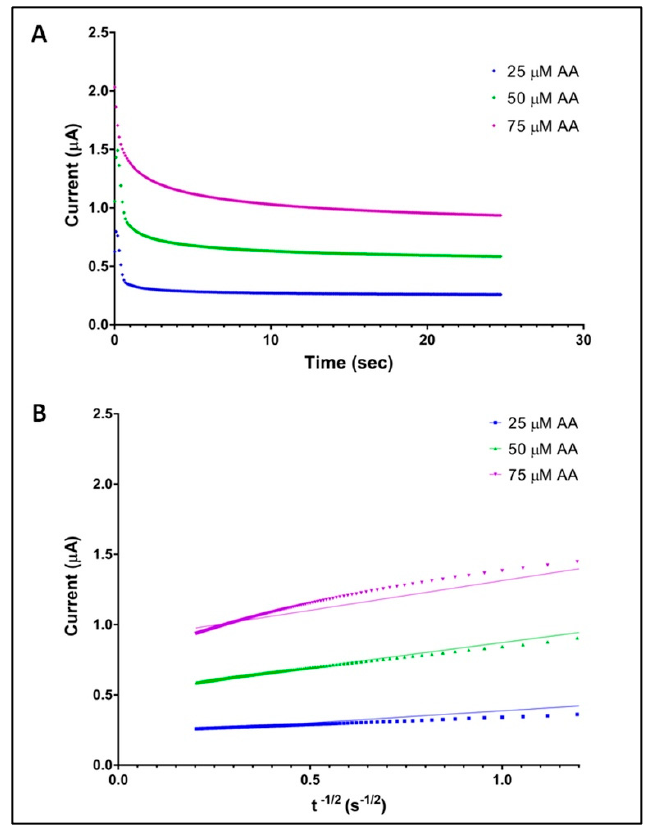
Figure 2. Chronoamperometries of SPE in PBS for different concentrations of ascorbic acid ( A ). Cottrell plots of I vs. t − 1/2 (s − 1/2 ) of the chronoamperometric data obtained for 25, 50 and 75 uM of AA ( B ).